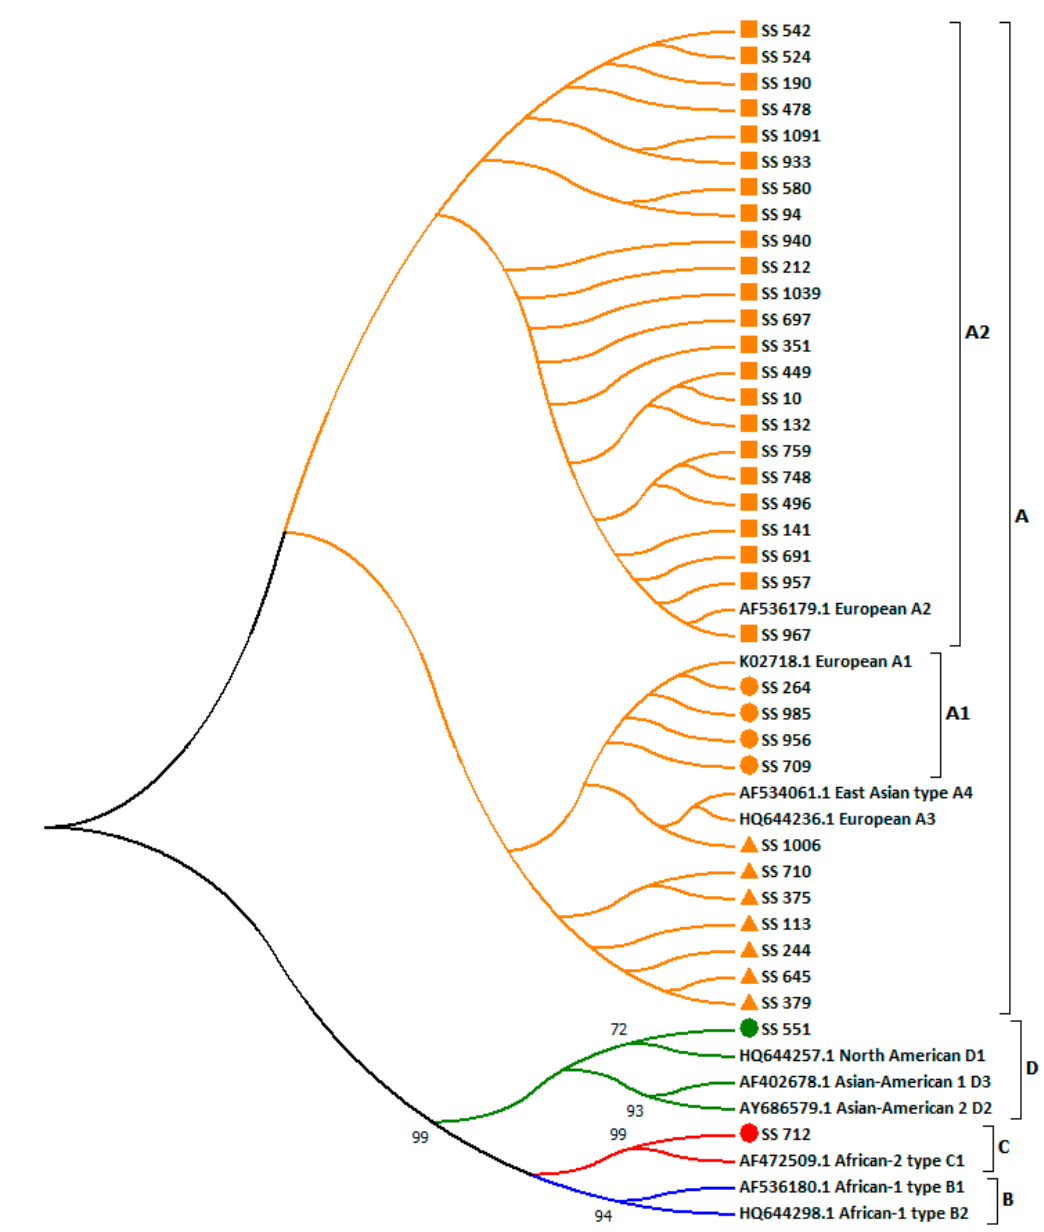
Figure 2. Evolutionary relationships of HPV16 sequences isolated from 36 women in the centre located in Sardinia. Sequences that belong to lineage A are highlighted in orange: circles identify sequences clustered to sublineage A1, rectangles sequences clustered to sublineage A2 and triangles sequences clustered to an unclear A sublineage, respectively. Sequences that cluster to lineages B, C and D are reported in blue, red and green, respectively. Of these, sequences isolated from women enrolled in this centre are marked with a circle. The evolutionary history was inferred using the Neighbor-Joining method. The optimal tree with the sum of branch length = 0.08407424 is shown. The evolutionary distances were computed using the Kimura two-parameter method. The analysis involved 46 nucleotide sequences. Evolutionary analyses were conducted in MEGA7.